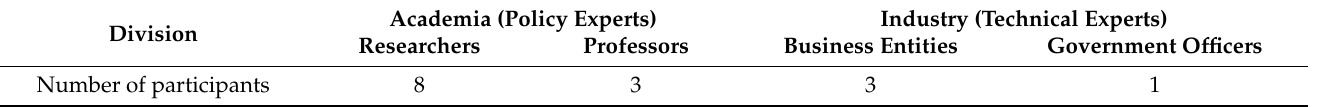
Table 2. Distribution of the P sample (participating